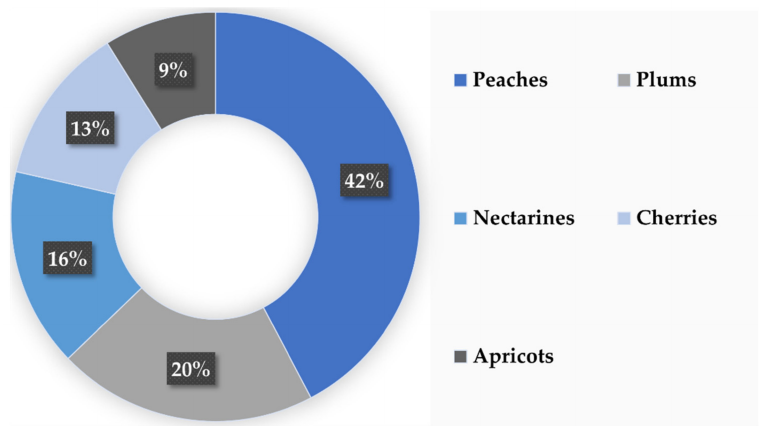
Figure 6. Proportion of stone fruit production in